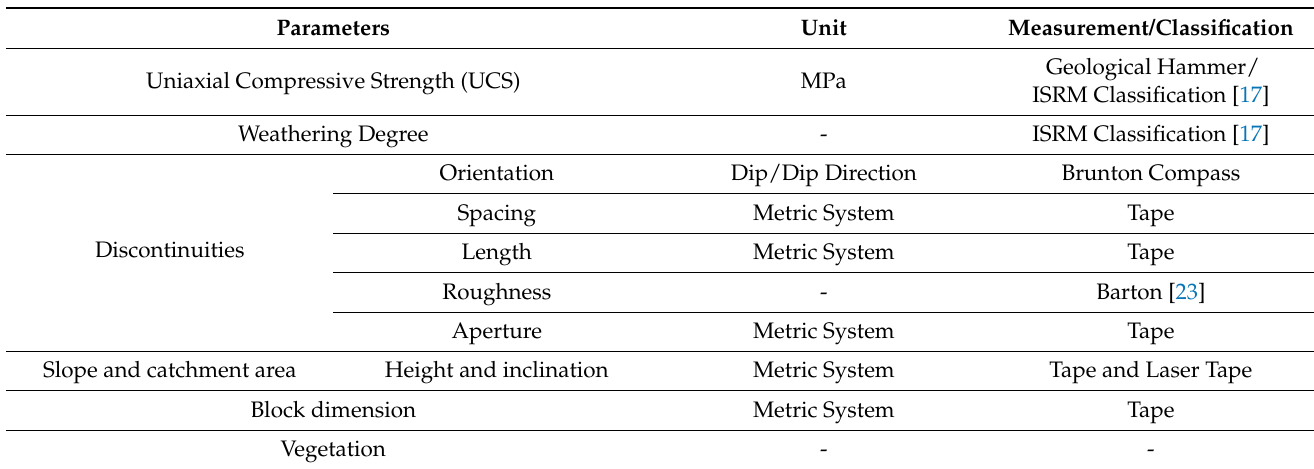
Table 4. Parameters surveyed in field.